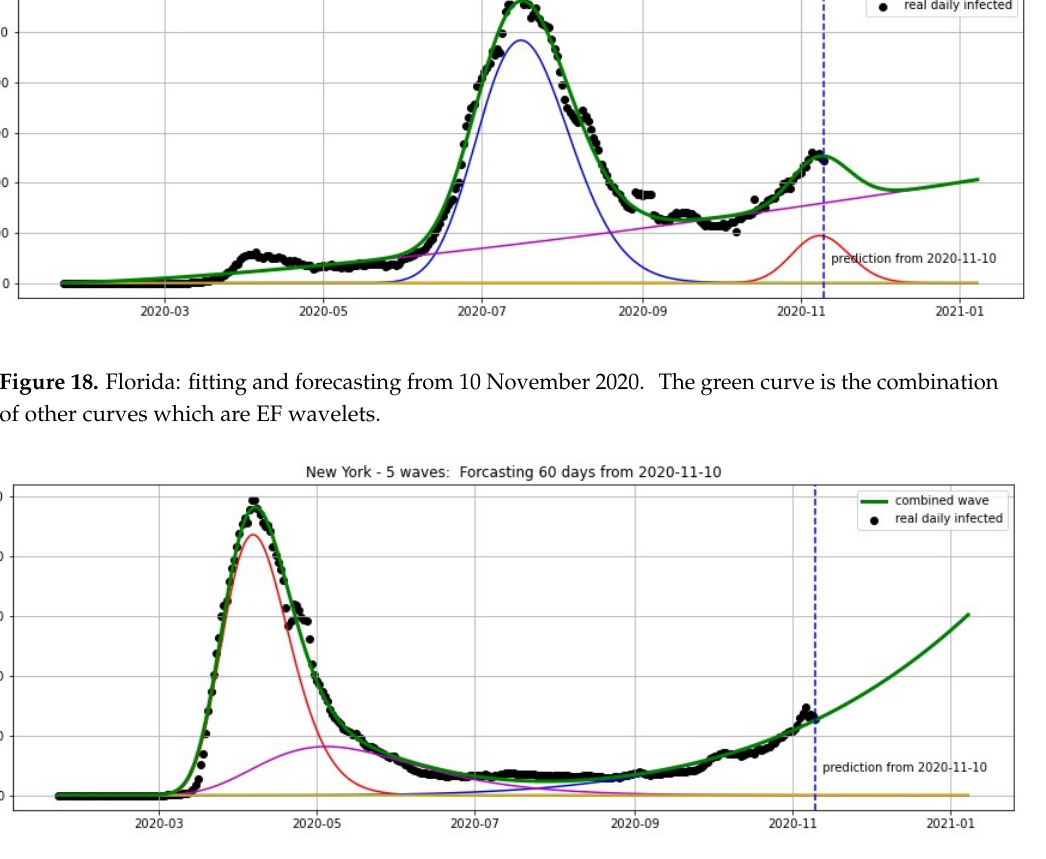
Figure 19. New York: fitting and forecasting from 10 November 2020. The green curve is the combination of other curves which are EF